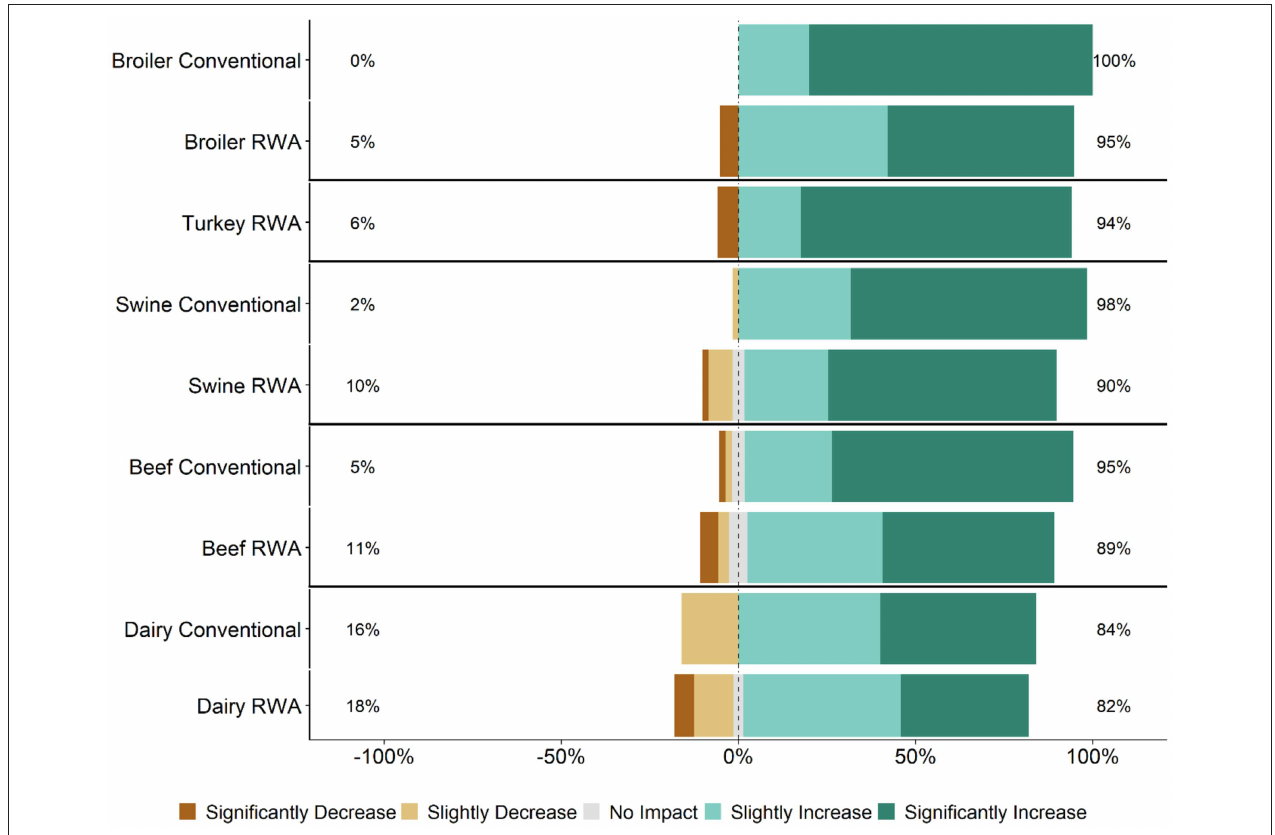
FIGURE 5 | Respondents’ opinion about the impact of RWA production on cost of production. Five-item Likert scale reporting respondents’ opinion, stratified by commodity and RWA experience.